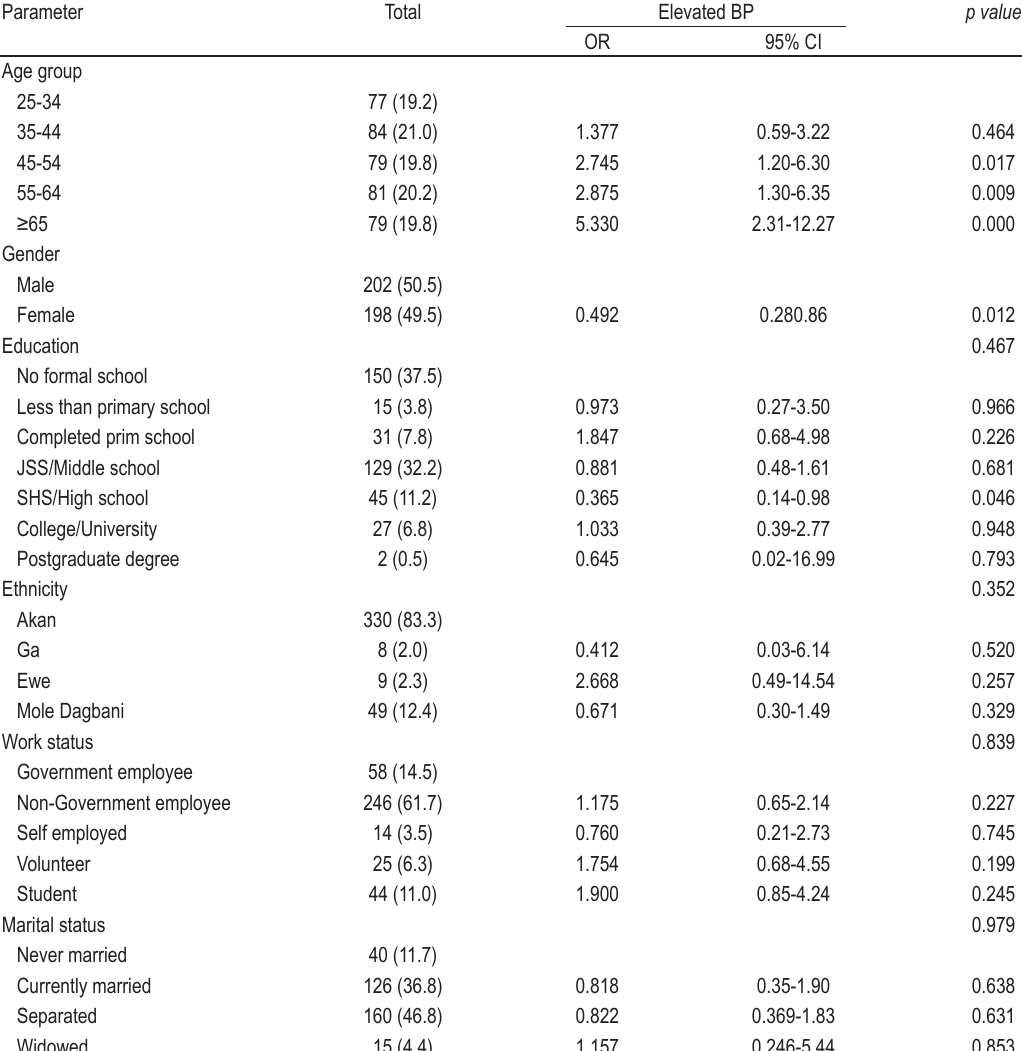
TABLE 4. Odds of HPT (SBP ≥140; DBP ≥90) among study participants and corresponding 95% CIs according to the demographic